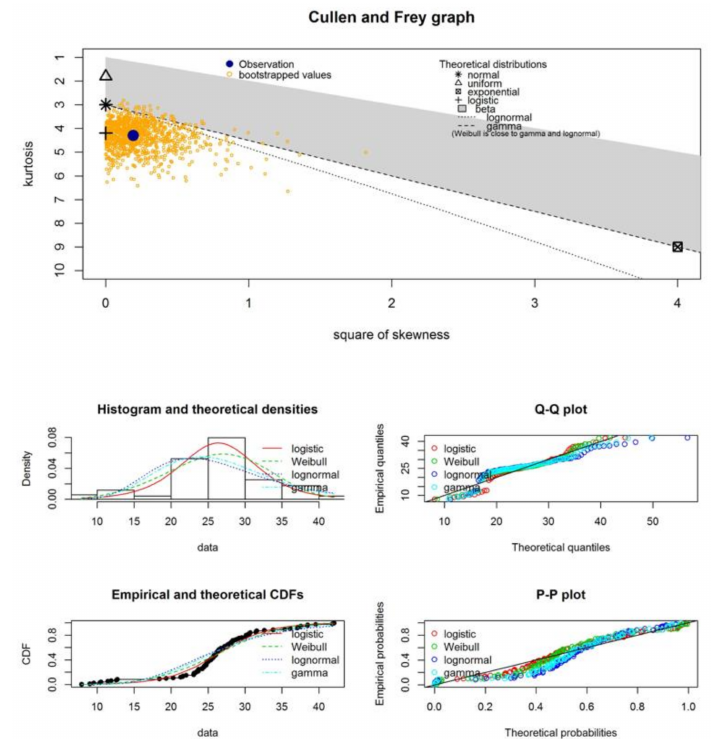
Figure A3. Statistical evaluation of nonwoven samples modified with hydrophilic agent: ( Top ) Cullen and Frey graph, and ( Bottom ) Probability density plot, cumulative distribution function, Q–Q plot, and P–P plot.